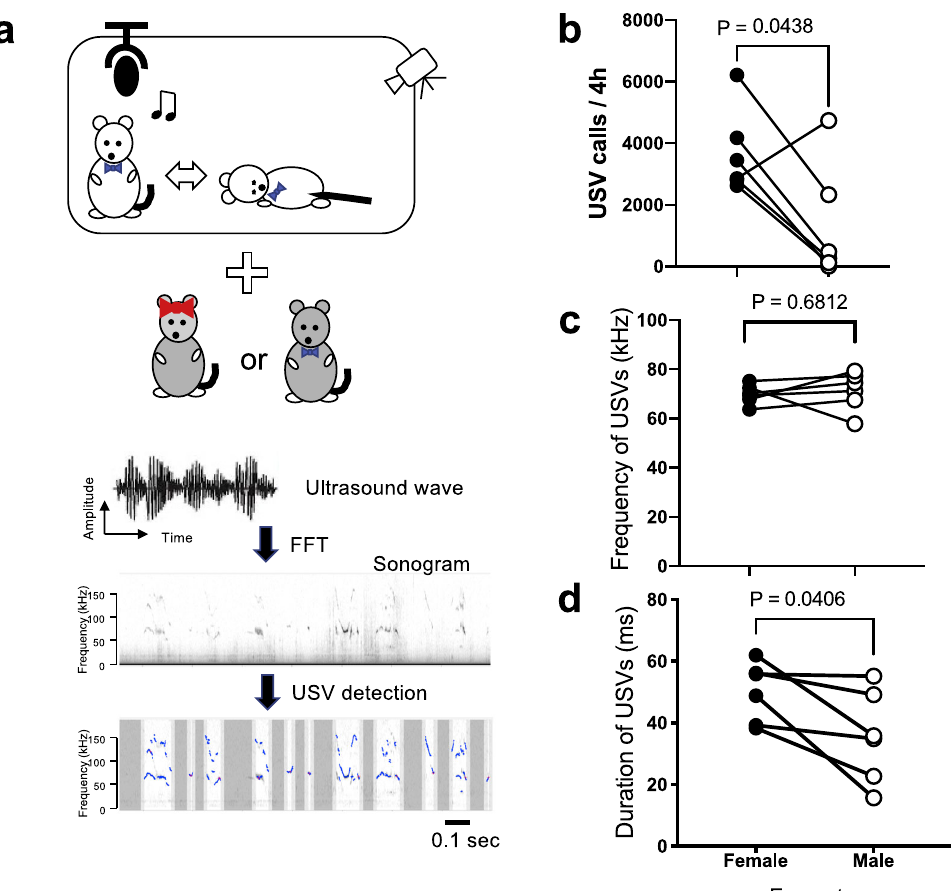
Fig. 2 Ultrasound vocalizations in orexin neuron-ablated mice. a Schematic explanation of the experiment. Behavior of an ORX-AB male mouse was videotaped together with recordings of the ultrasound vocalization with a female or a male encounter in his home cage for 4 h. Recorded ultrasound waves were analyzed of fl ine to detect syllables (USV calls) indicate blue line in the bottom fi gure. b The number of USV calls. c Average frequency of USV calls. d Average duration of USVs. Each ORX-AB mouse ( n = 6) was recorded twice; one with a female encounter and another with a male encounter. P values in the fi gure were obtained by paired t